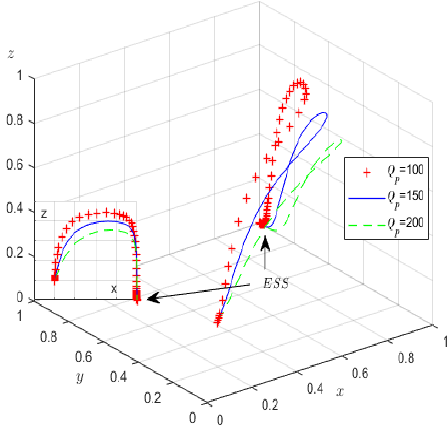
Figure 7. The influence of F p on evolutionary processes.